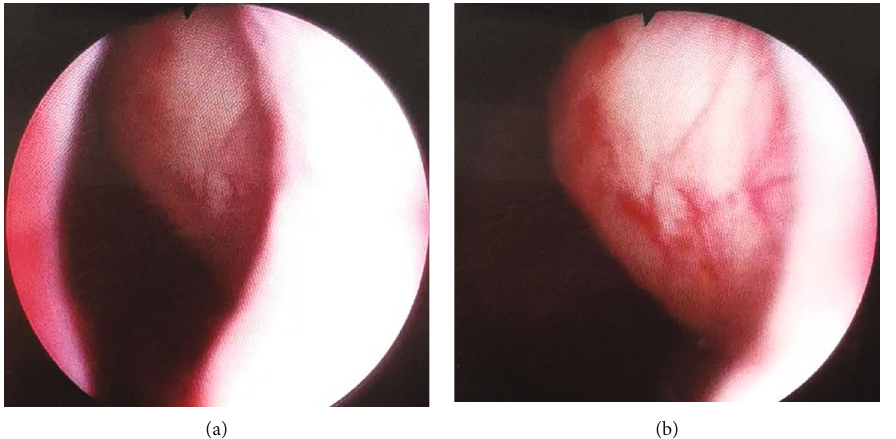
Figure 6: (a, b) Urethrocystoscopy showing a large intraluminal protruding mass at the left lateral trigonal area and partially obstructing the bladder